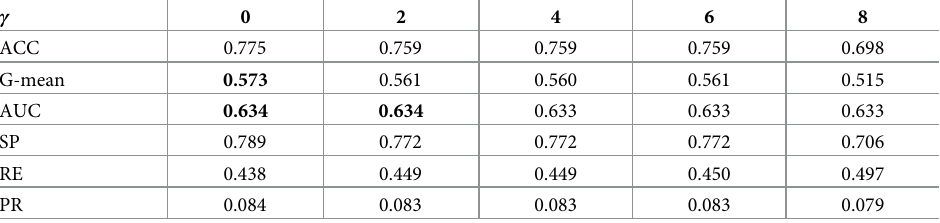
Table 11. Comparative analysis of CSDNN-FL versus γ using the Full Texas dataset. ACC, SP, PR, and RE repre- sents accuracy, specificity, precision, and recall, respectively. The highest G-mean and AUC values are denoted in bold. The parameter α is set as 0.97.